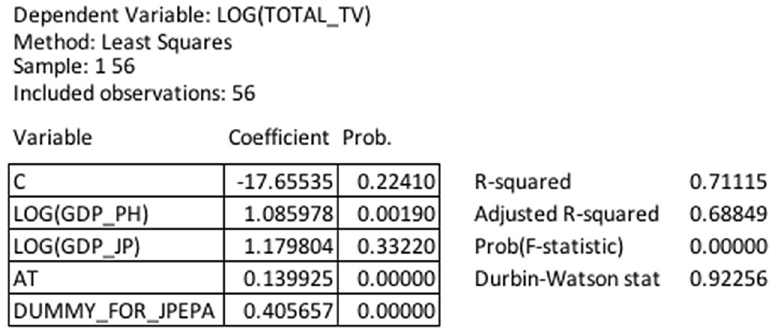
Table 1 Initial regression